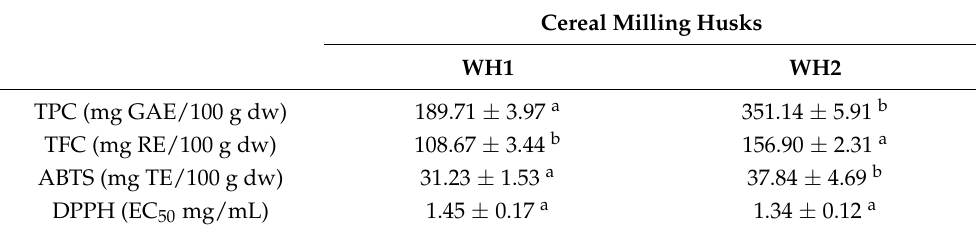
Table 4. Phenolic and Antioxidant Properties of SC durum wheat husk.